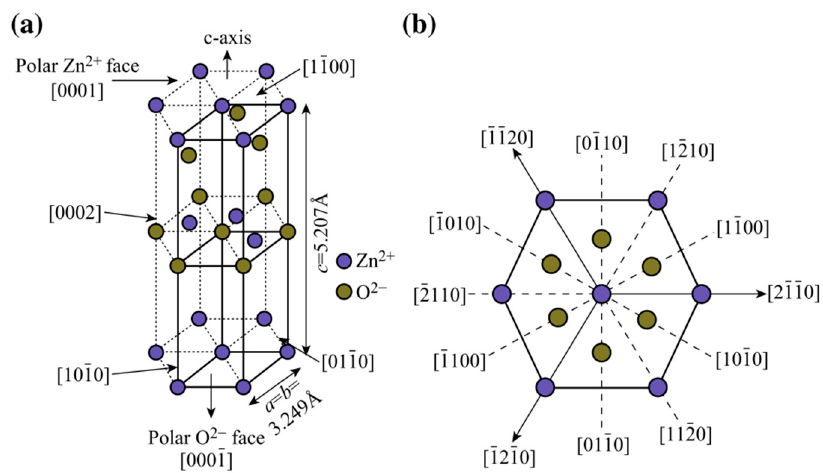
Figure 1. ( a ) ZnO unit cell with wurtzite structure. ( b ) Various crystal planes of the ZnO wurtzite structure [42]. structure